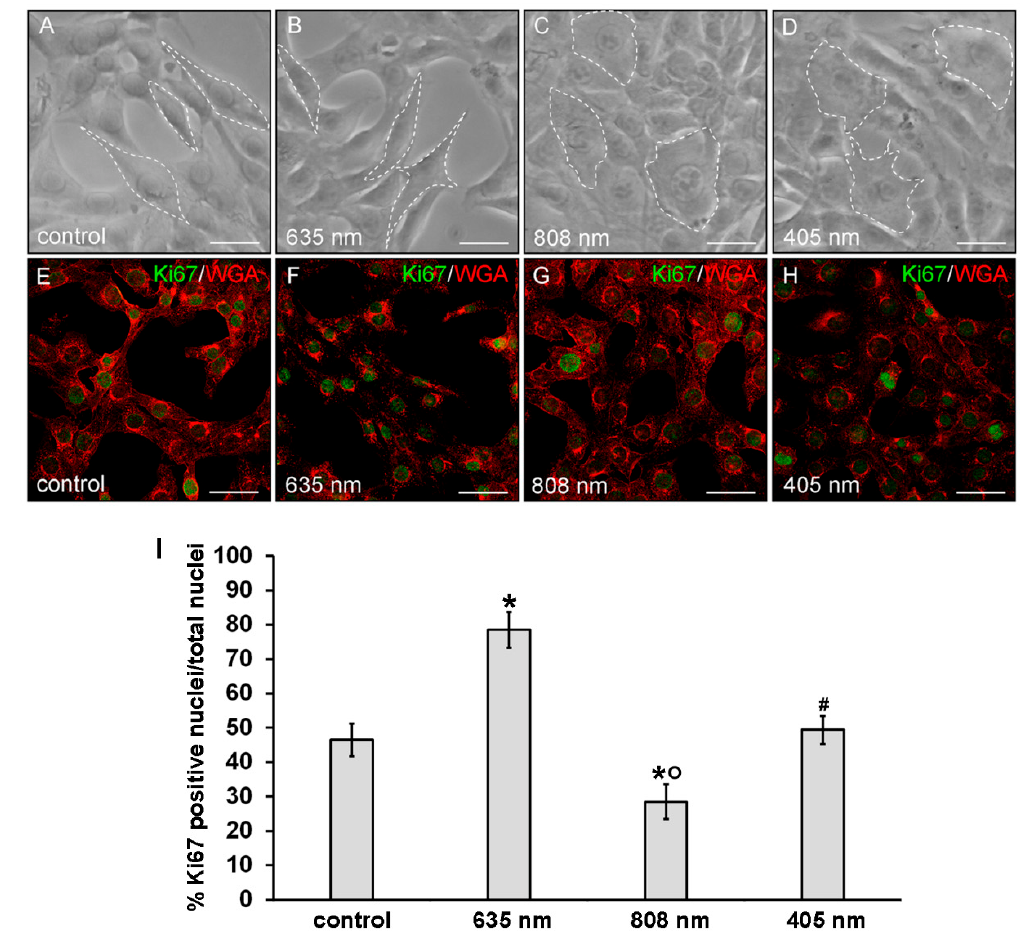
Figure 3. Evaluation of the morphology and of proliferation capability of NIH / 3T3 fibroblasts performed 24 h after cell exposure to red (635 nm), NIR (808 nm) and violet-blue (405 nm) PBM. Cells not subjected to PBM treatments served as control. ( A – D ) Representative phase contrast images of cells observed under an inverted phase contrast microscope. Scale bar: 20 µ m. White dotted lines were depicted to better visualize the cell shape. ( E – H ) Representative confocal fluorescence micrographs of fixed cells immunostained with antibodies against the nuclear proliferation marker Ki67 (green) and stained with Tetramethylrhodamine-conjugated WGA membrane dye (red). Scale bar: 50 µ m. ( I ) Histogram showing the percentage of cells with Ki67 positive nuclei. Significance of di ff erence: * p < 0.01 vs. control; ° p < 0.01 vs. 635 nm; # p < 0.01 vs. 808 nm; p = 0.06, 405 nm vs. control.